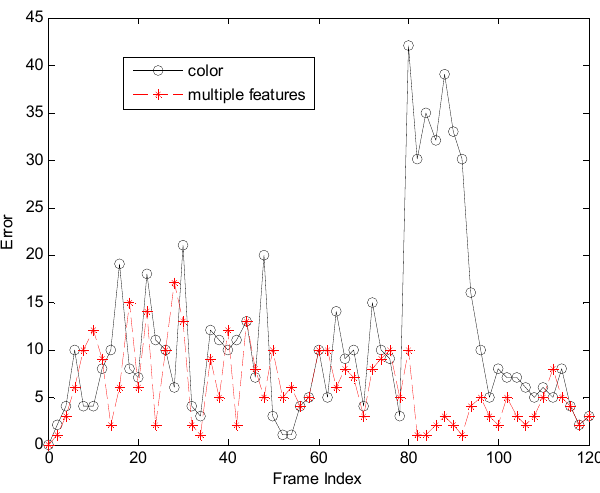
Figure 6. The RMSE comparison corresponding to background changes.